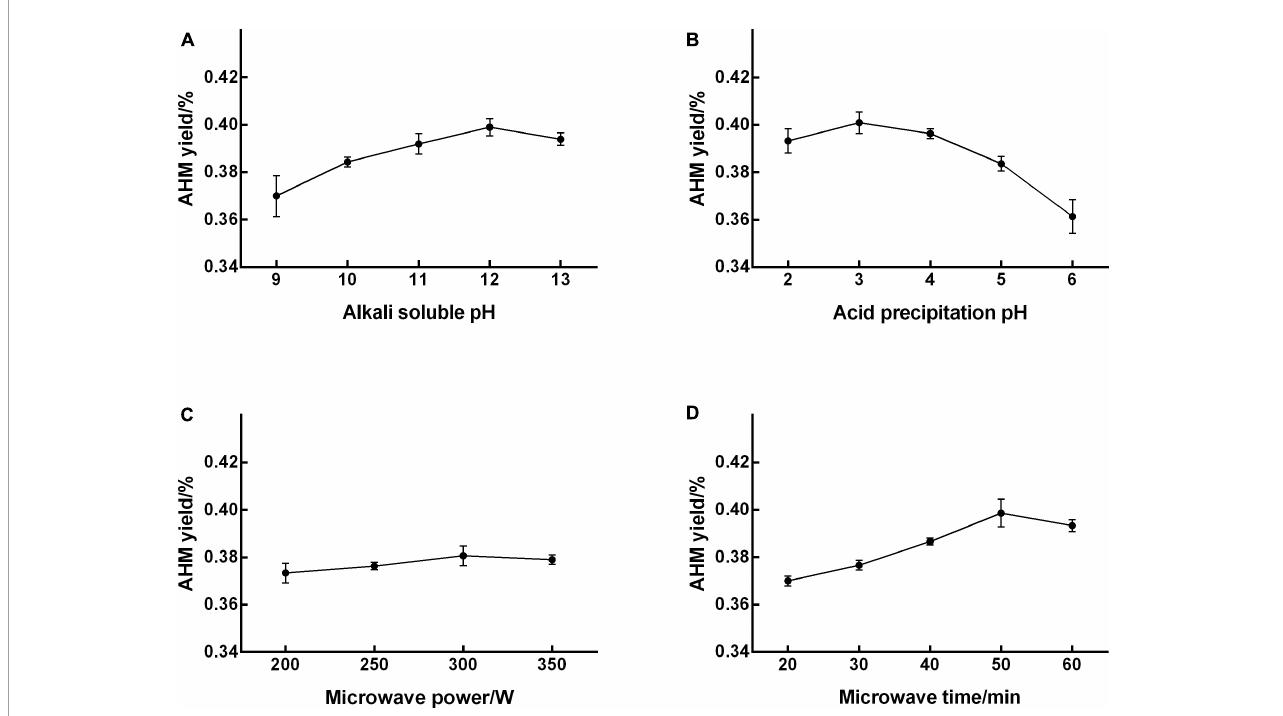
FIGURE1 Effect of single factors on the extraction yield of A. heimuer melanin (AHM). To determine the significant factors that affect AHM yield, a range of alkali-soluble pH (A) , acid precipitation pH (B) , microwave power (C) , and microwave time (D) were individually tested in the AHM extraction process.